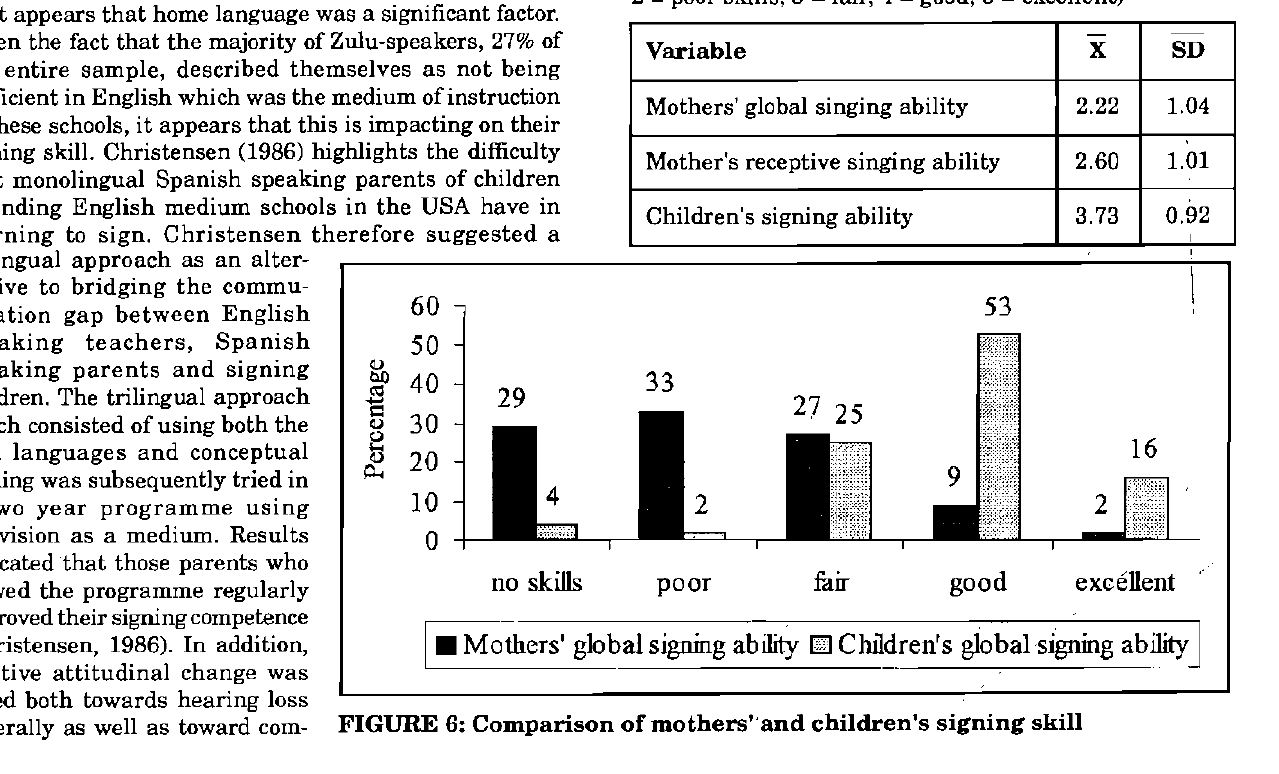
TABLE 4: Mother's rating of their own and their children's signing skill